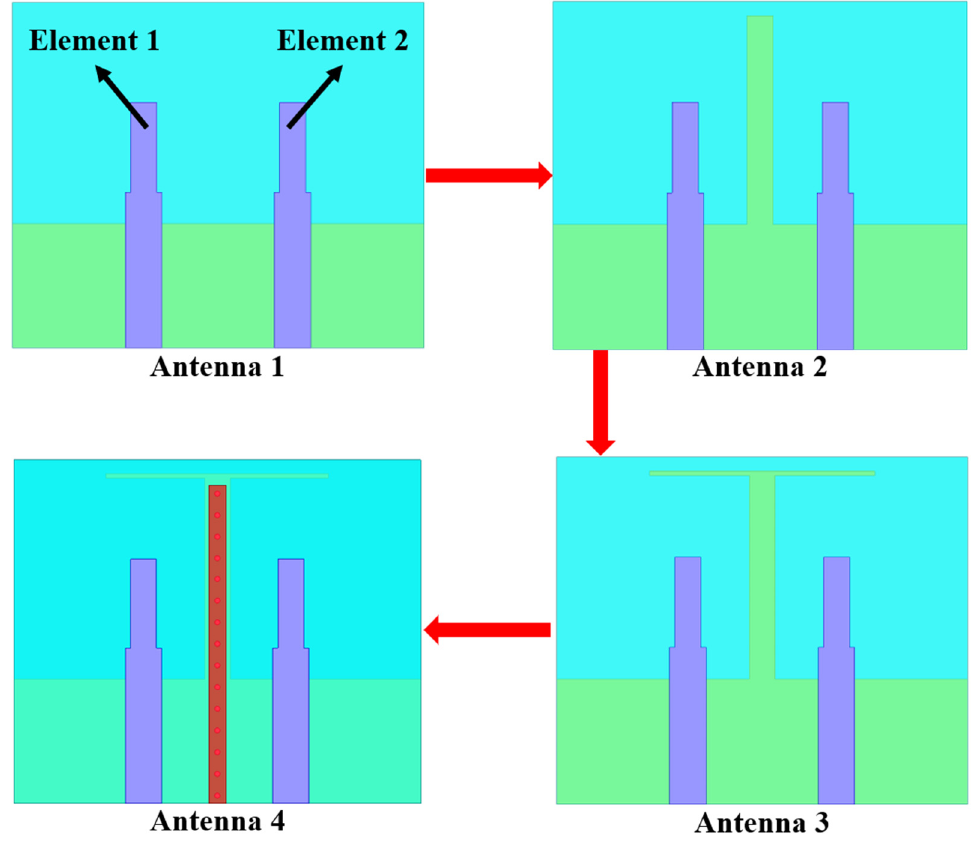
Figure 2. The design evolution of the proposed MIMO antenna.